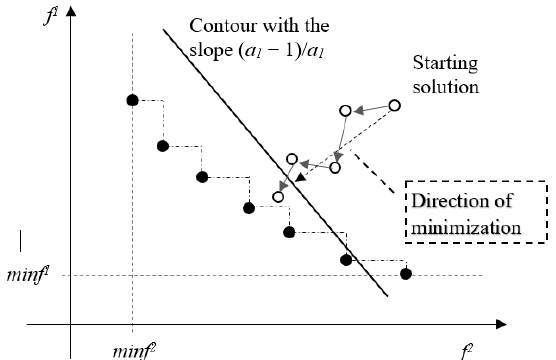
Figure 2. The black circles correspond to the Pareto front members, and the empty circles denote the solutions met during the minimization process.